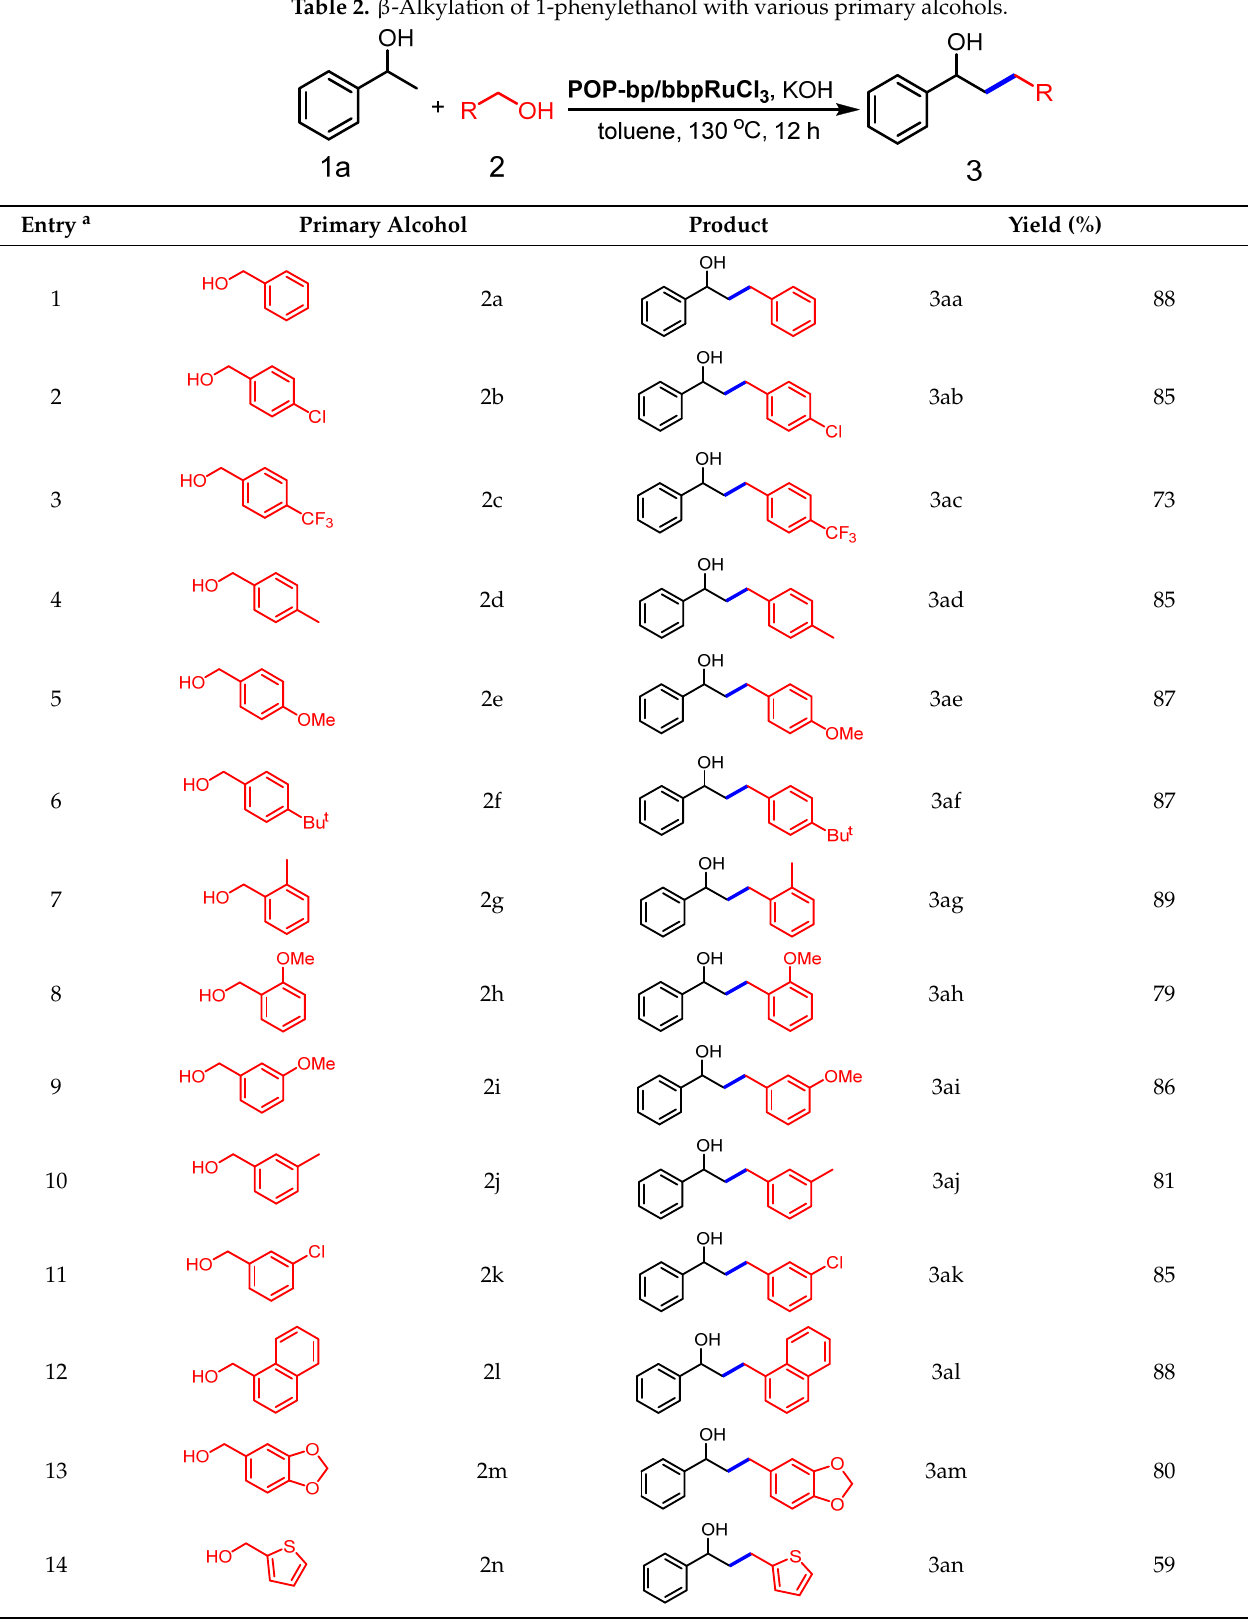
Entry a Entry a Entry a